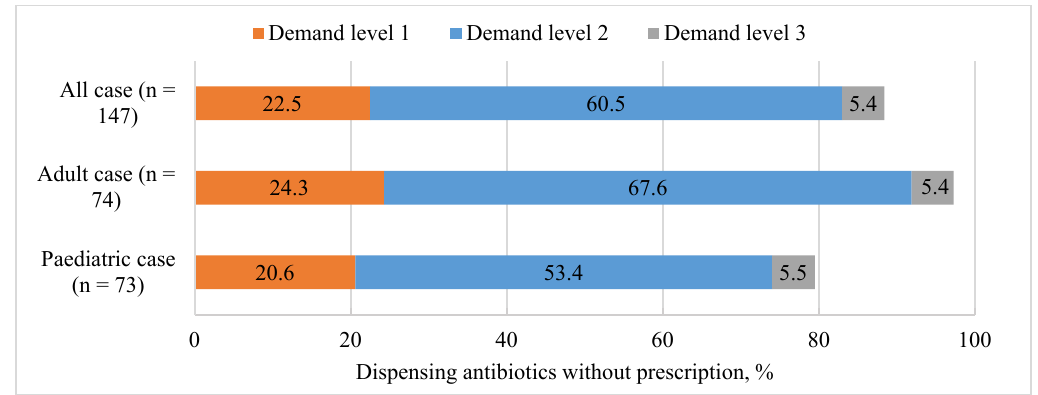
Figure 1. Proportions of dispensing antibiotics without a prescription in three different levels of demand. Demand level 1 (client required some medicine for cough), Demand level 2 (client explicitly expressed the requirement of antibiotic), Demand level 3 (client specifically required roxithromycin).